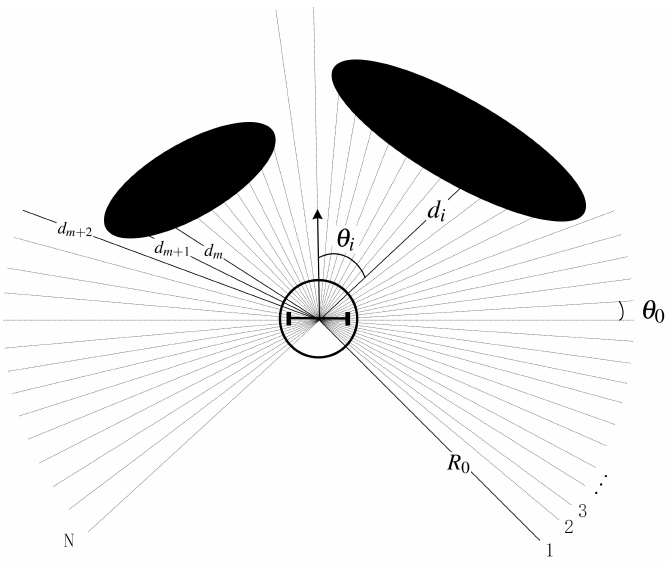
Figure 1. Flow diagram of the approach in one time interval.